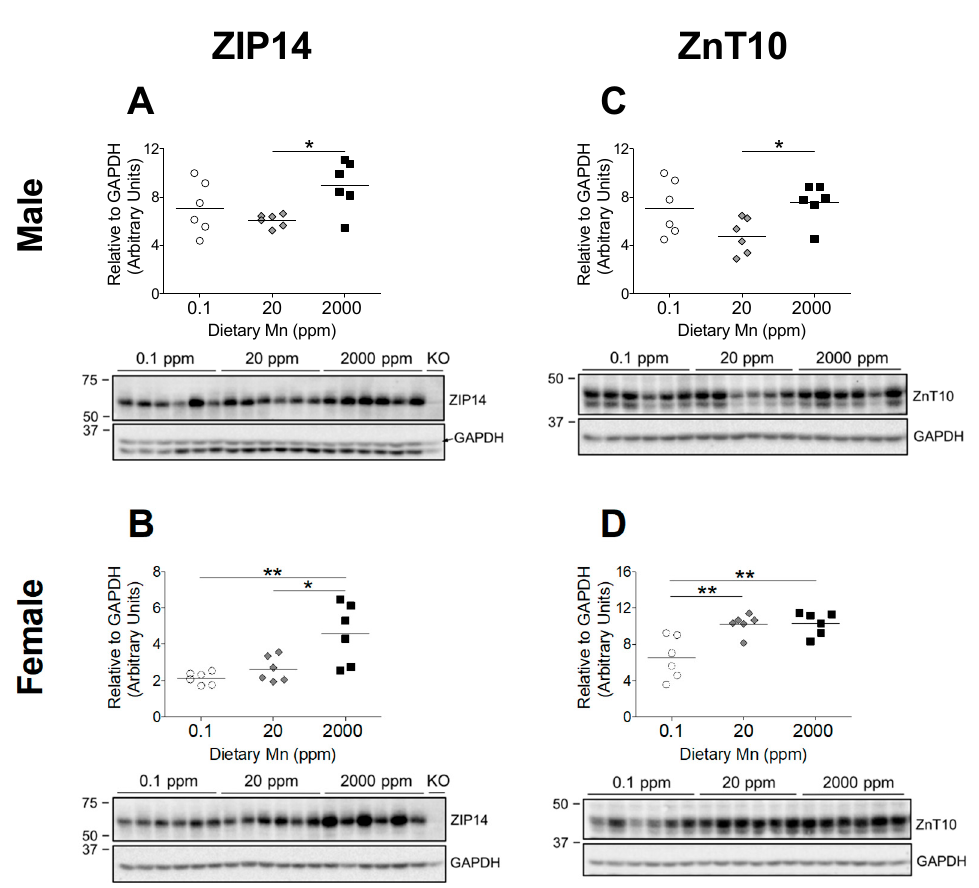
Figure 6. Comparison of transporter protein levels in the liver. Expression of (A and B) ZIP14 and (C and D) ZnT10 in male and female mice on 0.1, 20, and 2000 ppm Mn diets ( n = 6/sex). Liver samples were obtained at 12 weeks of age and analyzed via western blot. Quantifications of protein levels were performed using GAPDH as a loading control. ZIP14 blots also include results from an age-matched Zip14 knockout (KO) mouse as a control (fed traditional rodent diet). Data expressed as mean ± SEM. * p < 0.05, ** p < 0.01.